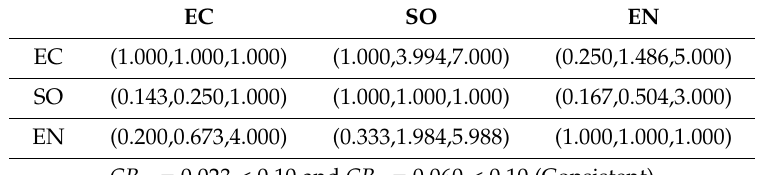
Table A6. Fuzzy pairwise comparison matrix with respect to the green innovation